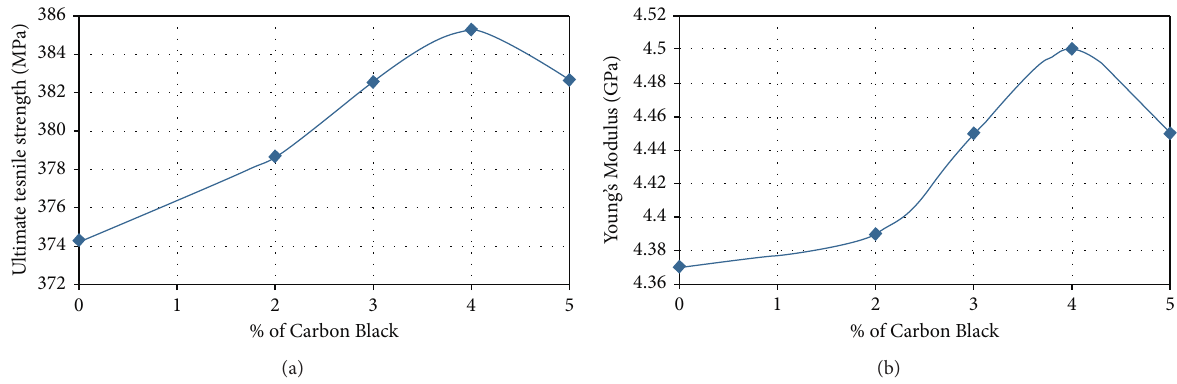
Figure 5: (a) Effect of carbon black on ultimate tensile strength of the vinyl ester composites. (b) Effect of carbon black on Young’s modulus of the vinyl ester composites.